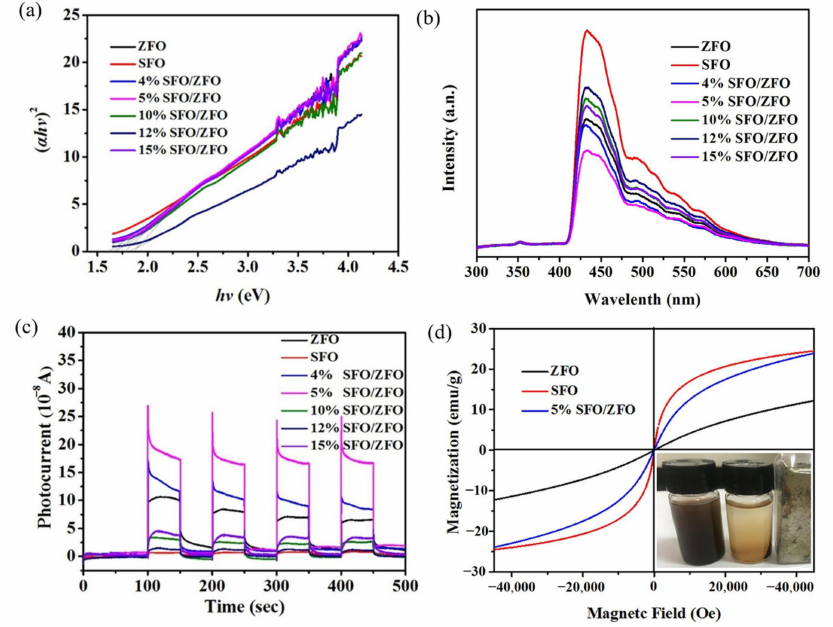
Figure 12. The pure ZnFe 2 O 4 , pure SnFe 2 O 4 , and SnFe 2 O 4 /ZnFe 2 O 4 nano-heterojunctions: ( a ) plots of (ahv) 2 versus hv; ( b ) PL spectra; ( c ) photocurrent responses; ( d ) magnetization curve [103] (reprinted with permission from [103] Wang et al.,